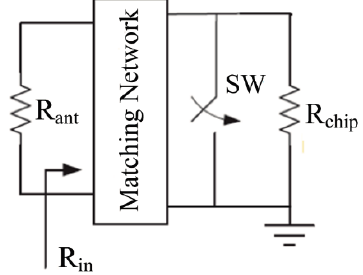
Figure 2. ASK backscattering